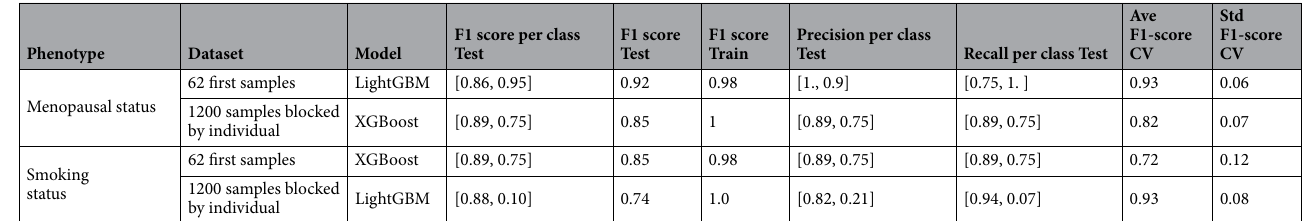
Table 3. Summary of predictive performance of the best ML models for classification tasks. Three ML models (RF, LightGBM, XGboost) have been evaluated on different subsets of the Canada cohort (62 samples taken from each subject at the first time point, and 1200 time series samples blocked by individual). When applied to time series samples, the ML models have been tuned and trained blocking by individual, e.g., samples of the same subjects are not present both in the training and test datasets. The table reports F1-score, precision and recall per class as computed on the test dataset, weighted average F1-score on the test, training datasets and on cross validation. The table reports the performances scores of the best fine-tuned model per dataset and phenotype, while Supplementary Table 2 shows the full